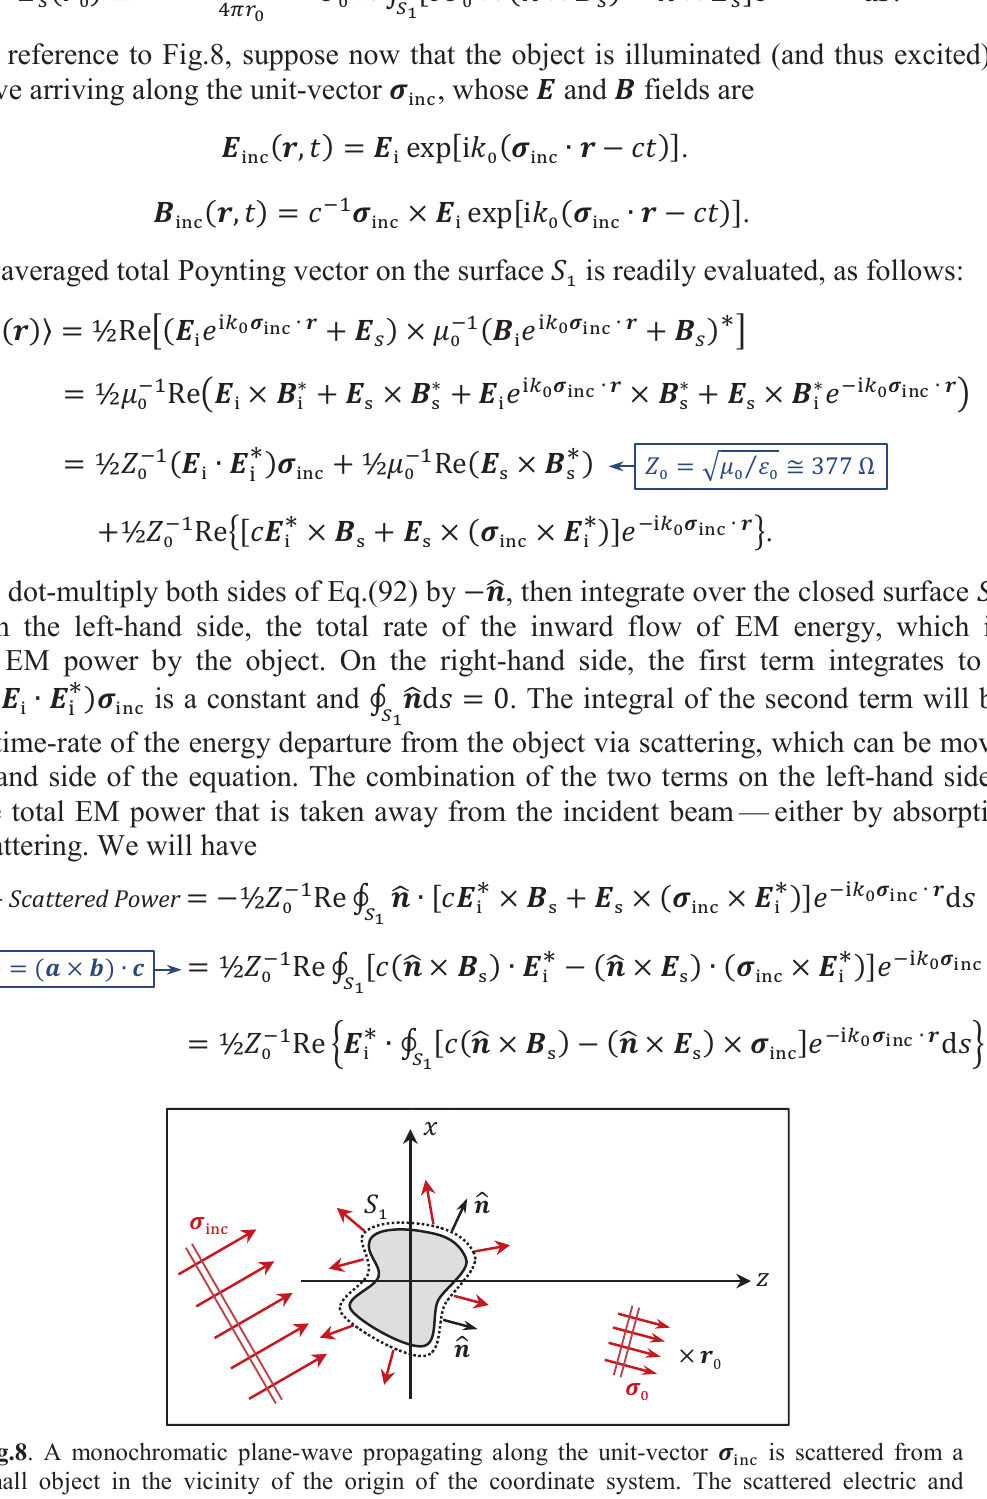
surrounding the object are denoted by (cid:2161) (cid:3117) are outward directed. The scattered light reaching (cid:3117)